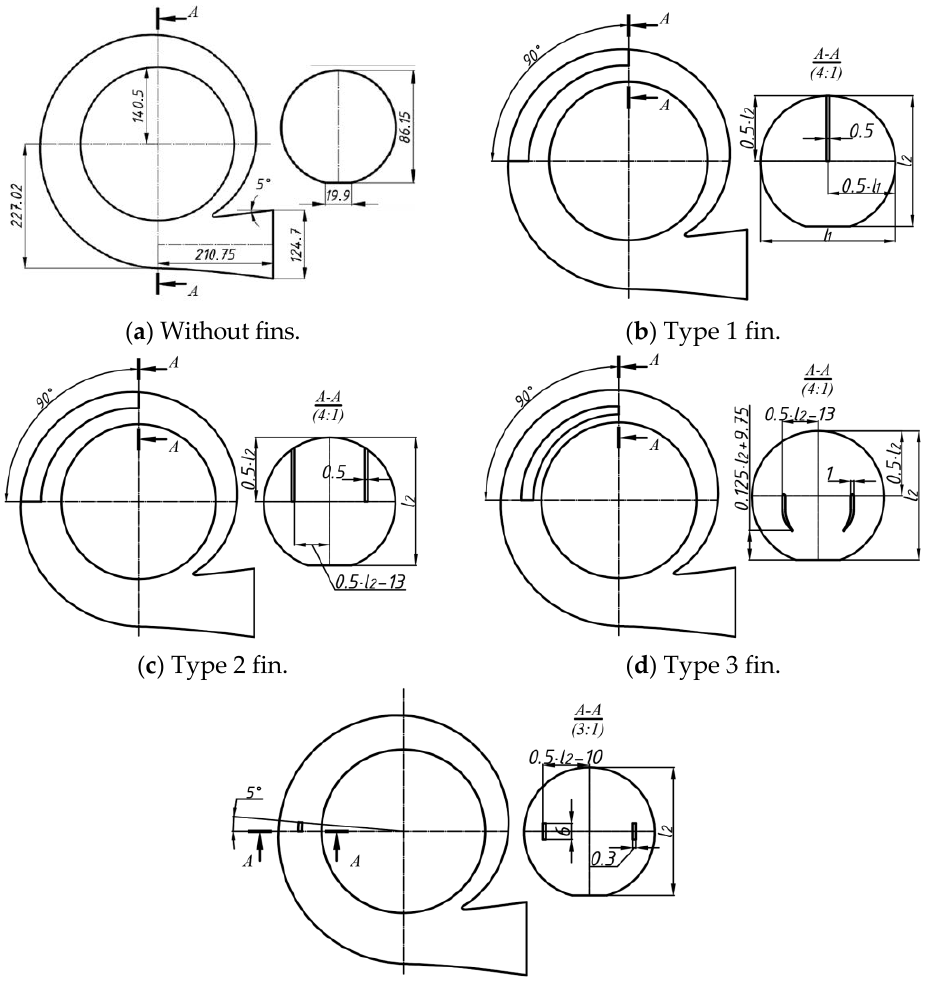
Figure 1. Schemes of the investigated inlet pipes of a low power turboexpander.